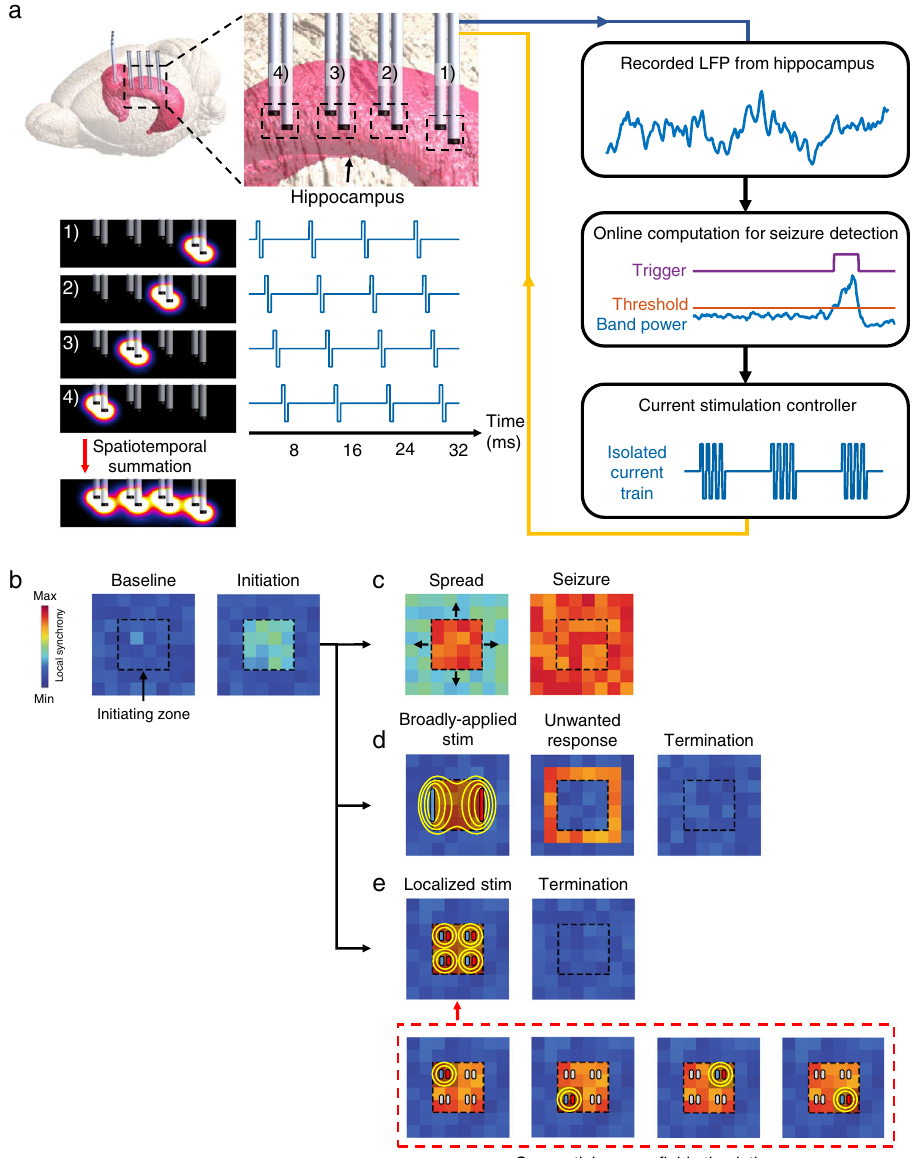
Fig. 1 | Overview of the SNF stimulation strategy. a Diagram of the closed-loop on-demand SNF stimulation system. Multi-channel electrode arrays are implanted in the bilateral hippocampalregions. The recordedsignals from multiple locations are fed into the real-time seizure detection algorithm based on features of signal frequency and power. Once a seizure has been detected with the computed thresholds for each channel, localized stimulus pulses are applied to the overall